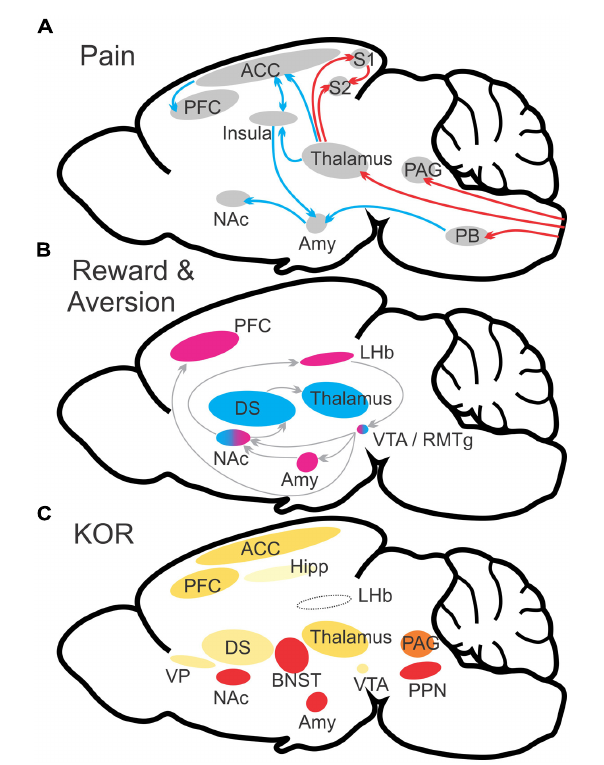
FIGURE 1 | Schematic illustration of major brain networks involved in pain and reward processes (A,B). (A) Ascending projections convey pain signaling to multiple brain structures including the periaqueductal gray, thalamus, and parabrachial nucleus. Continued and distinct processing occurs for both sensory (red arrows) and affective (blue arrows) dimensions of pain perception. (B) Reward/aversion processes involve multiple overlapping and interacting networks. Shown are the major structures involved in reward (blue) and aversion (magenta). (C) KOR abundance in relevant brain structures. Heat map color-coded (Red = most abundant) by reported radioligand binding (Mansour etal., 1987; Le Merrer etal., 2009). ACC, anterior cingulate cortex; Amy, amygdala; BST, bed nucleus of the stria terminalis; DS, dorsal striatum; LHb, lateral habenula; NAc, nucleus accumbens; OFC, orbitofrontal cortex; PAG, periaqueductal gray; PB, parabrachial nucleus; PFC, prefrontal cortex; PPN, pedunculopontine nucleus/pedunculopontine tegmental nucleus; S1, primary somatosensory cortex; S2, secondary somatosensory cortex;VP, ventral pallidum;VTA, ventral tegmental area. (A,B) adapted from Cahill etal.